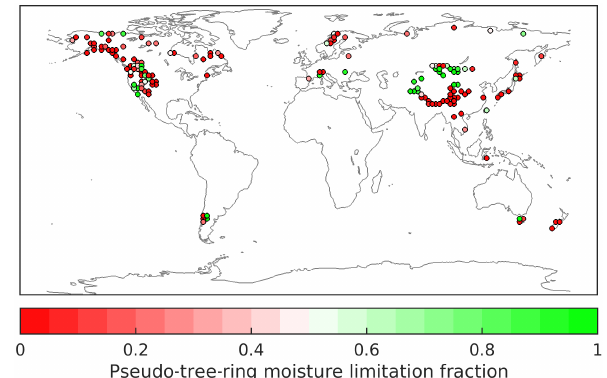
Figure 3. Moisture limitation fraction for each pseudo-tree ring, with green values indicating more moisture-limited sites and red values indicating more temperature-limited sites. A value of 0 in- dicates a pseudo-tree site that is completely temperature limited, while a value of 1 indicates a completely moisture-limited